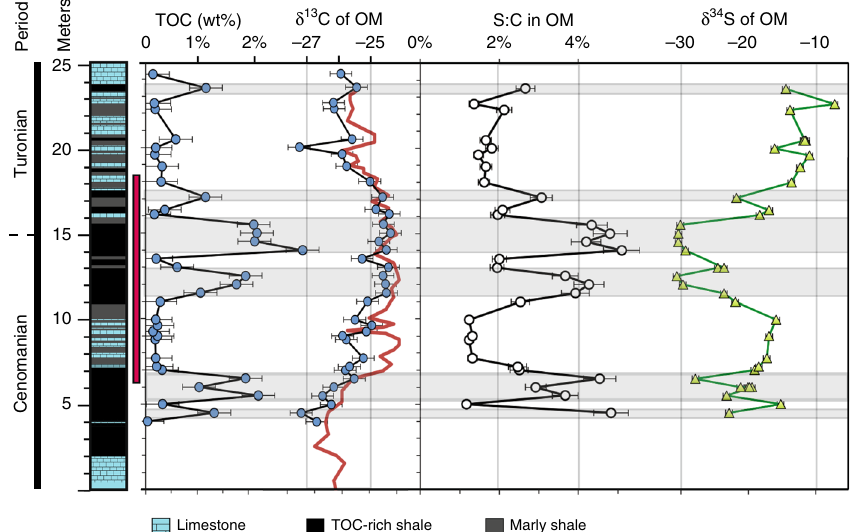
Fig. 1 Stratigraphic pro fi les of organic sulfur and carbon geochemistry at Pont d ’ Issole. Total organic carbon (TOC) concentrations, δ 13 C values (in permil ( ‰ ) vs. the VPDB standard), S:C (mol/mol) ratios, and δ 34 S values (in ‰ vs. the VCDT standard) show clear and coherent variations with depth. Stratigraphy at left is from 25,29 and the red bar indicates the positive C-isotope excursion as in 25 . Shaded bands highlight intervals with TOC concentrations >1.0%. For organic carbon δ 13 C pro fi les, the red line shows data from 25 , while blue symbols are new data for our samples. Error bars indicate the reproducibility of representative external replicates ( n ≥ 3). Where OM is abundant, it is associated with relatively high molar S:C ratios and low δ 34 S